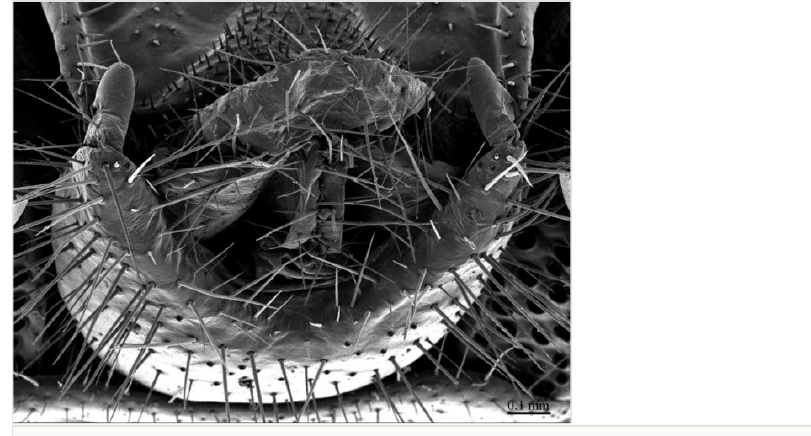
Figure 11. Eupolybothrus cavernicolus Komerički & Stoev sp. n., male paratype. Genitalia, posterio-dorsal